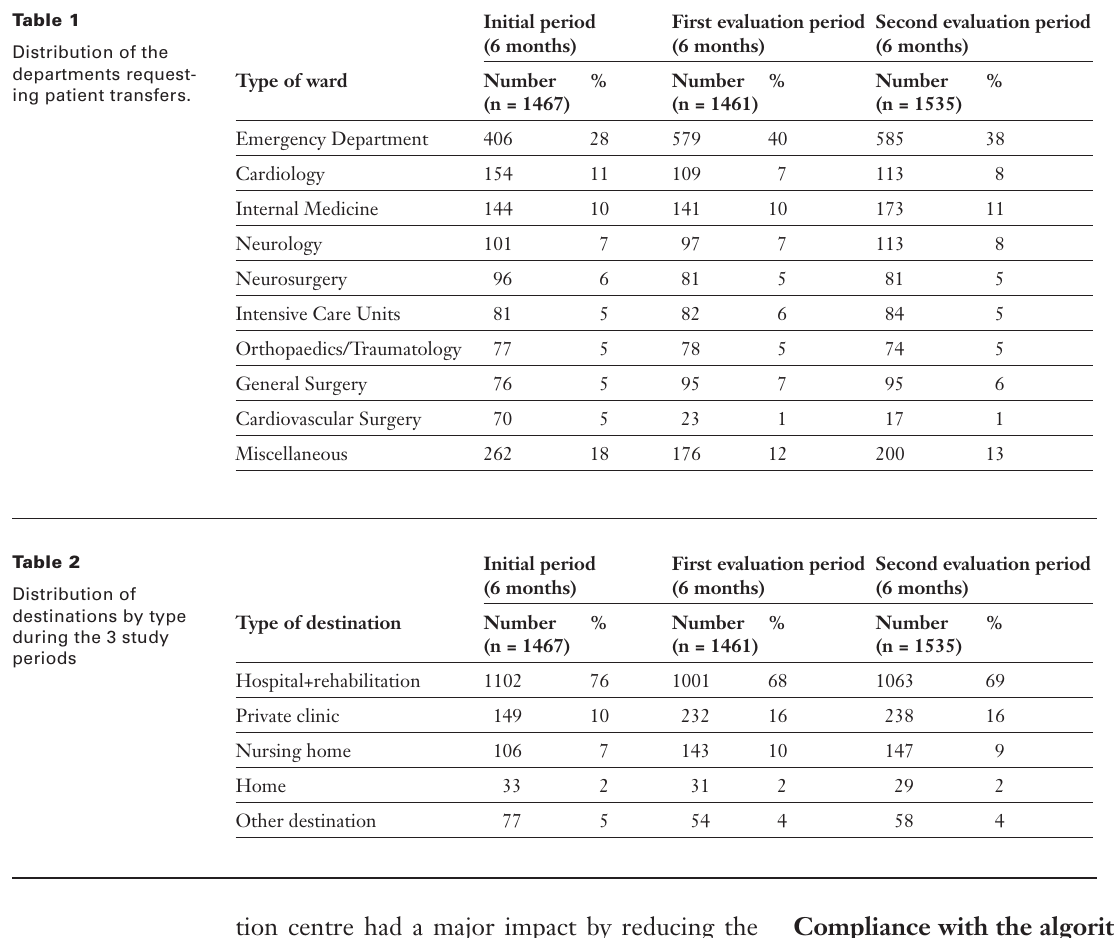
Distribution of the departments request- ing patient transfers.